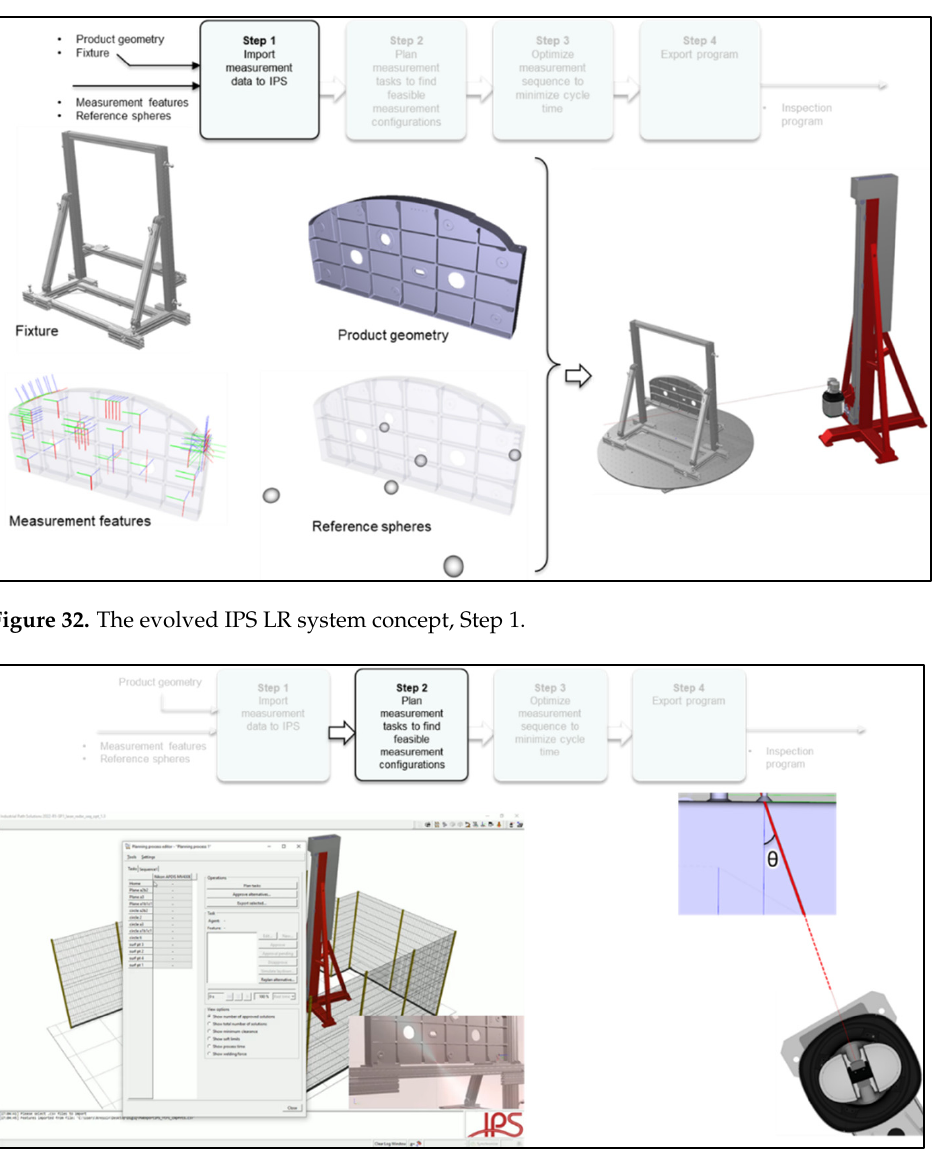
Figure 33. The evolved IPS LR system concept, Step 2.